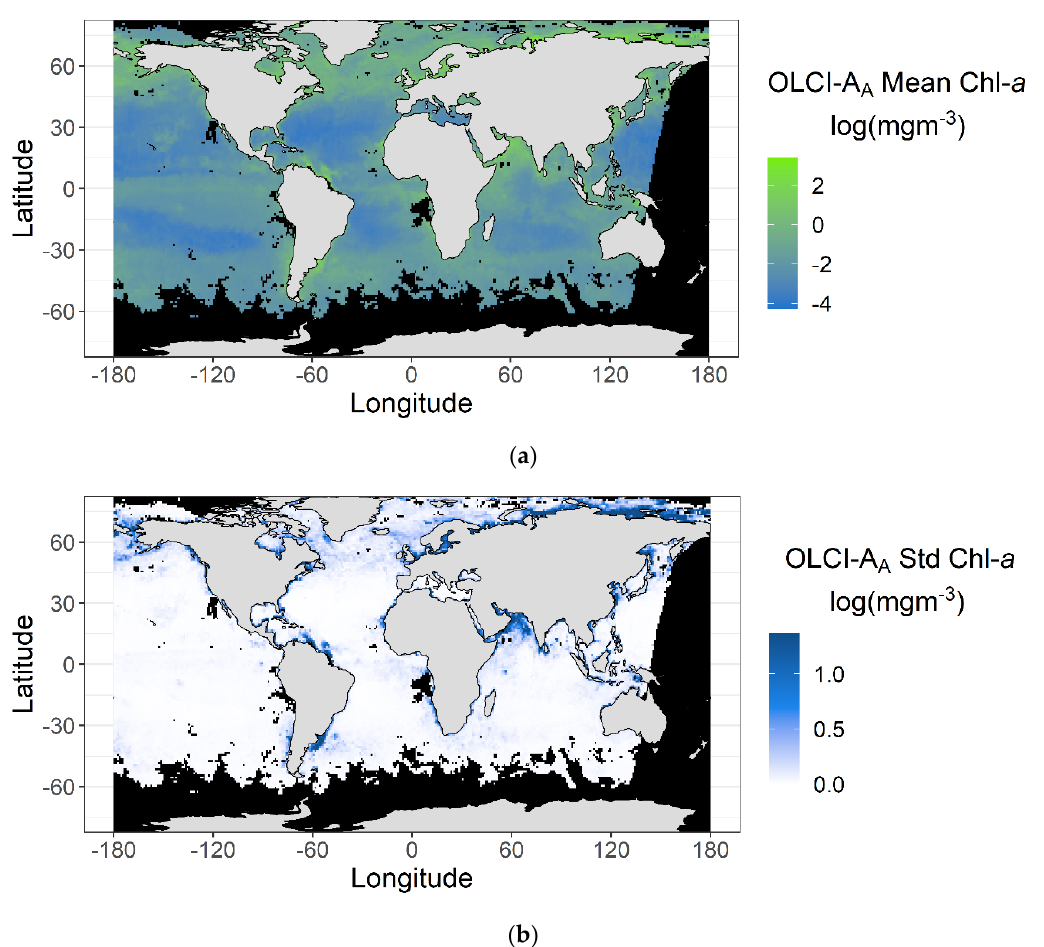
Figure A8. Global maps at 1° resolution of the OLCI-A-Aligned chl- a ( a ) mean and ( b ) standard deviation over the tandem period. Black grid cells indicate missing data.